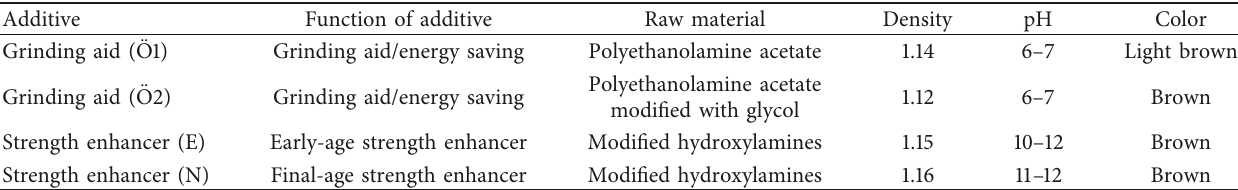
Table 2: Properties of cement additives.